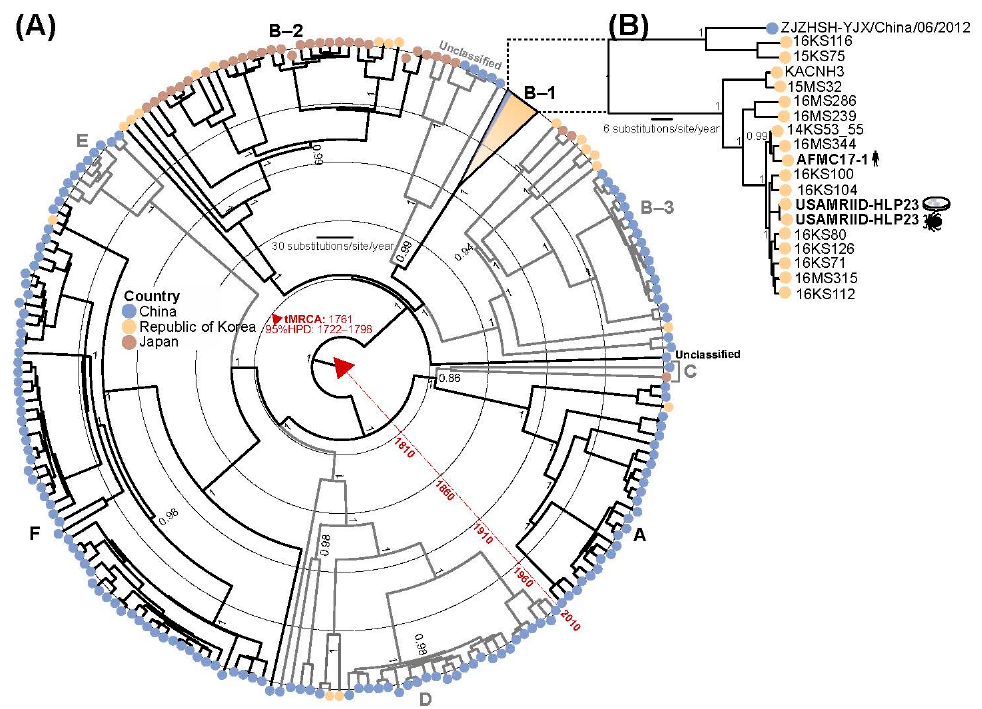
Figure 4. Radial maximum-clade credibility trees estimated using ( A ) 207 and ( B ) 19 B-1 genotype concatenated coding-complete SFTSV genomes. Circles at tree tips are colored by country of isolation. Time to the most recent common ancestor (tMRCA) and the 95% highest posterior densities (HPD) are shown. Posterior support > 0.7 is displayed for major tree nodes. Strain names of sequences generated in this study are shown in bold along with host / source information and other B-1 genotype sequences. Tree branches are scaled by substitutions per site per year. The inset tree ( B ) contains recently published sequences from KOR that are not included in ( A ) [38] .